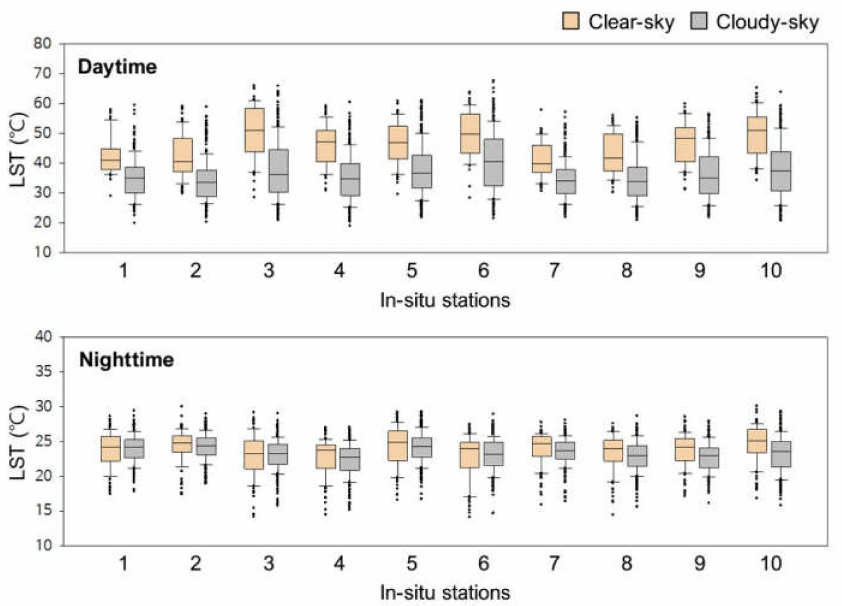
Figure 4. Boxplots of bias-corrected in situ LSTs under clear and cloudy skies for daytime and nighttime for each station. Refer to Figure 1 for station